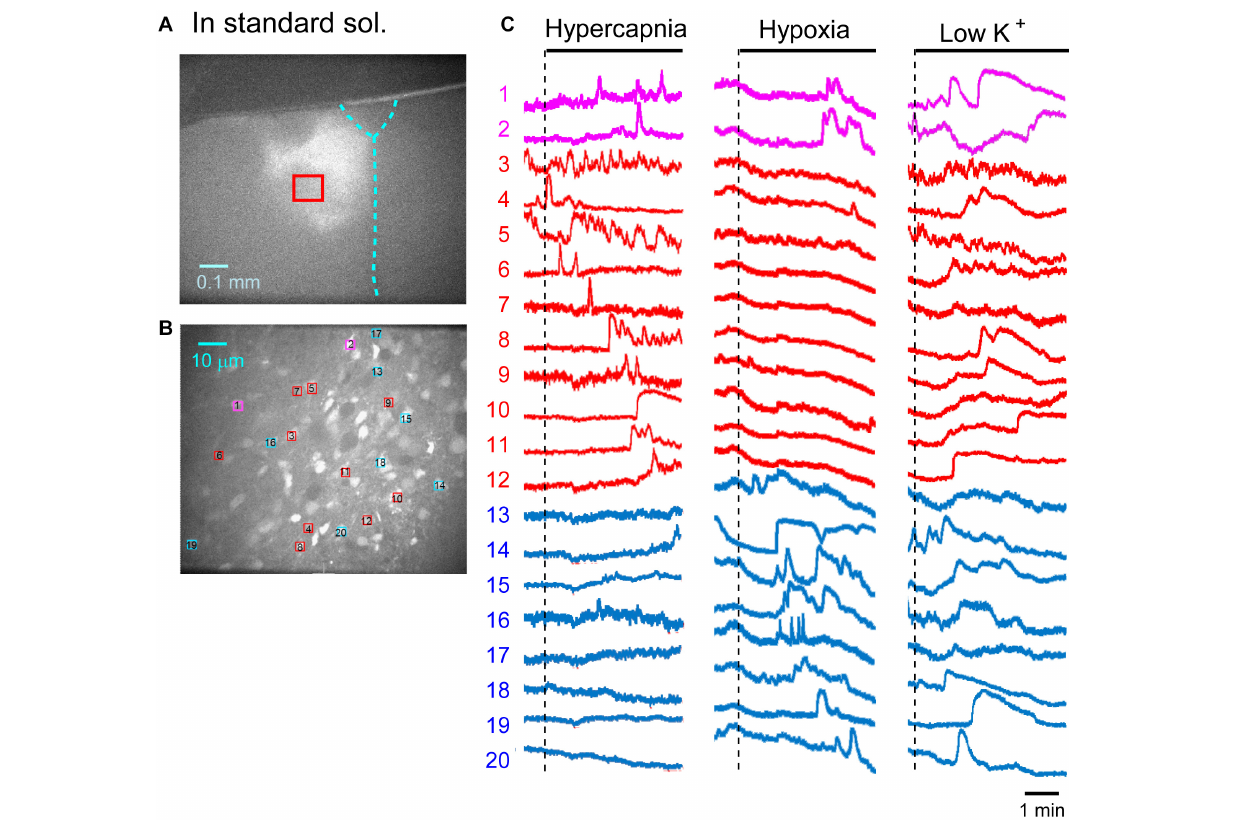
FIGURE 2 | Calcium imaging in the NTS in standard solution (sol.). (A) Low-magnification image of the cut surface where Oregon Green was injected and calcium imaging was performed. (B) Optical image of the cut surface stained with Oregon Green. The red square in (A) corresponds to the measured area shown in (B) . (C) Calcium signals plotted as fluorescence intensity in identified NTS cells numbered in the image in (B) in response to hypercapnia (left), hypoxia (middle) and low K + (right) stimulation. Magenta traces denote calcium signal intensity of cells (Nos. 1 and 2) responding to stimulation of both hypercapnia and hypoxia. Red traces denote calcium signal intensity of cells (Nos. 3–12) responding only to hypercapnia. Blue traces denote calcium signal intensity of cells (Nos. 13–20) responding only to